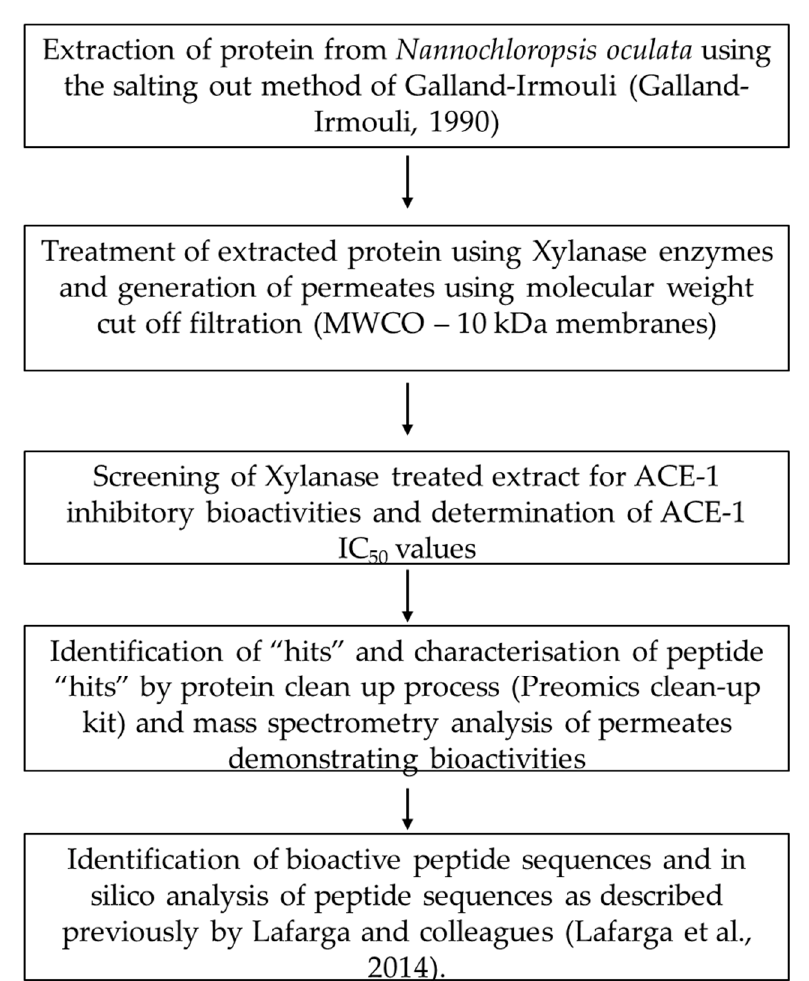
Figure 1. Workflow diagram of processes applied to generate bioactives from Nannochloropsis oculata [22,23] .